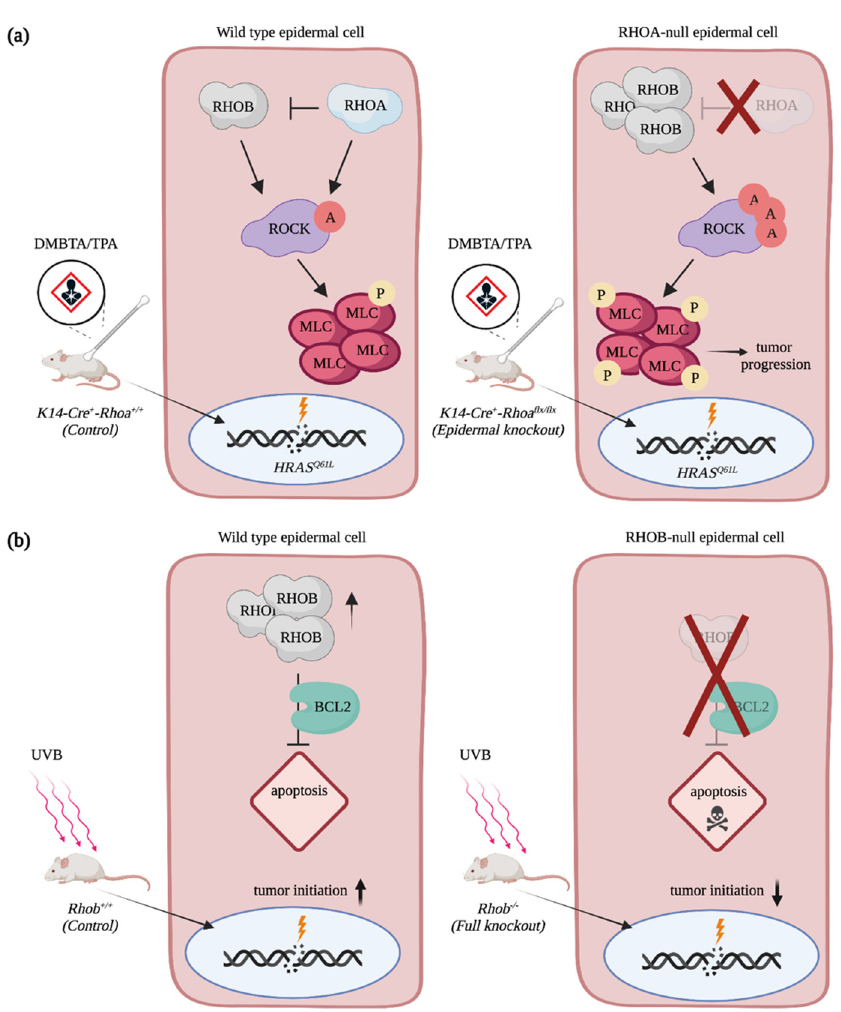
Figure 4. RHOA and RHOB contribution to cSCC progression. ( a ) RHOA impedes cSCC progression by restricting levels of RHOB in HRAS Q61L -transformed keratinocytes. In the RHOA-null epidermal cells, RHOB levels are increased, which promotes RHO-mediated signaling. ( b ) RHOB protects cells from UVB-induced apoptosis via BCL2, which enables cutaneous tumor formation. In the RHOB-null epidermal cells, UVB exposition promotes cell death. A = activation, P = phosphorylation. Created with BioRender.com, accessed on 20 August